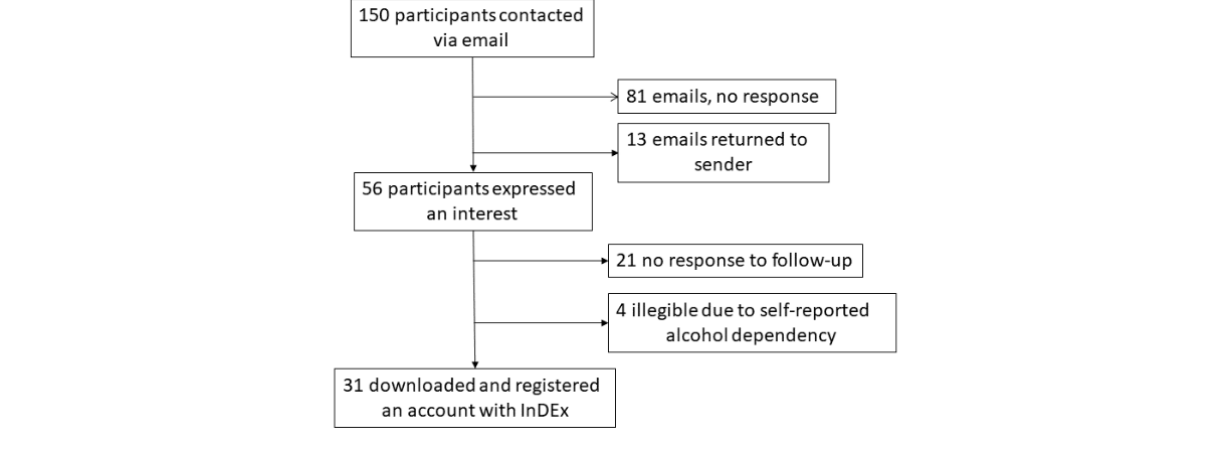
Figure 3. Participant flow through the study.